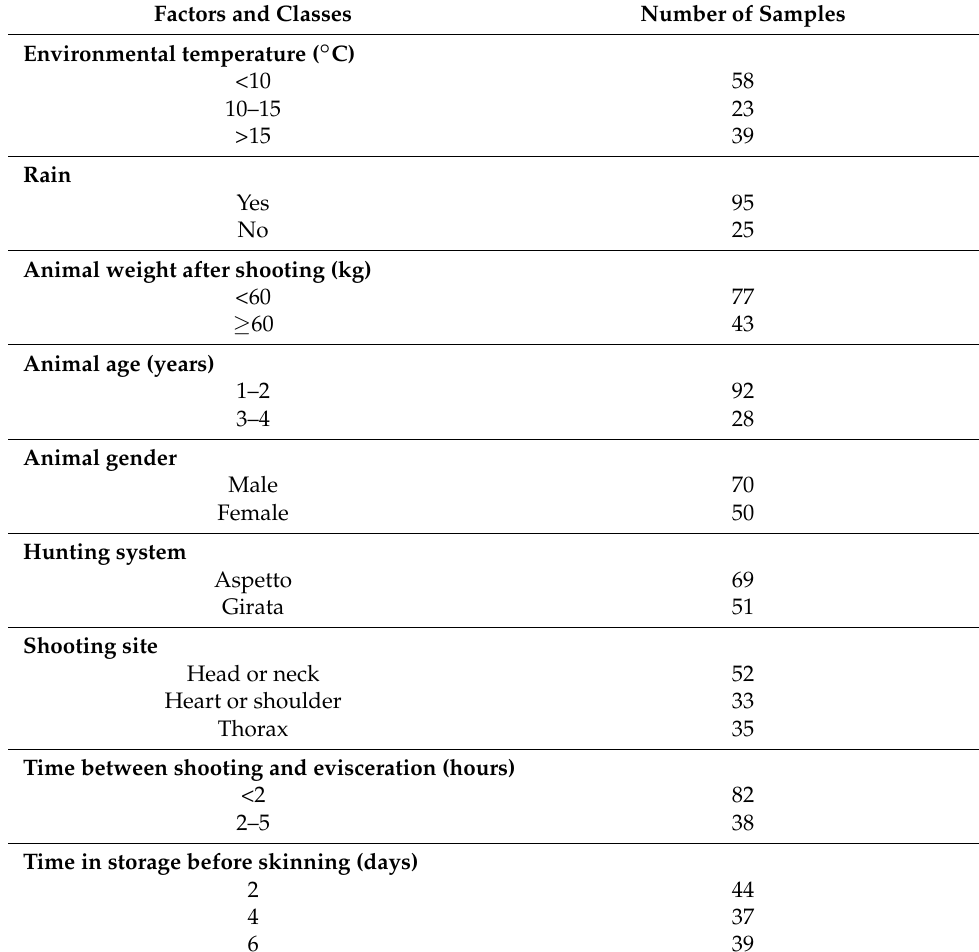
Table 1. Distribution of samples according to the hunting questionnaire